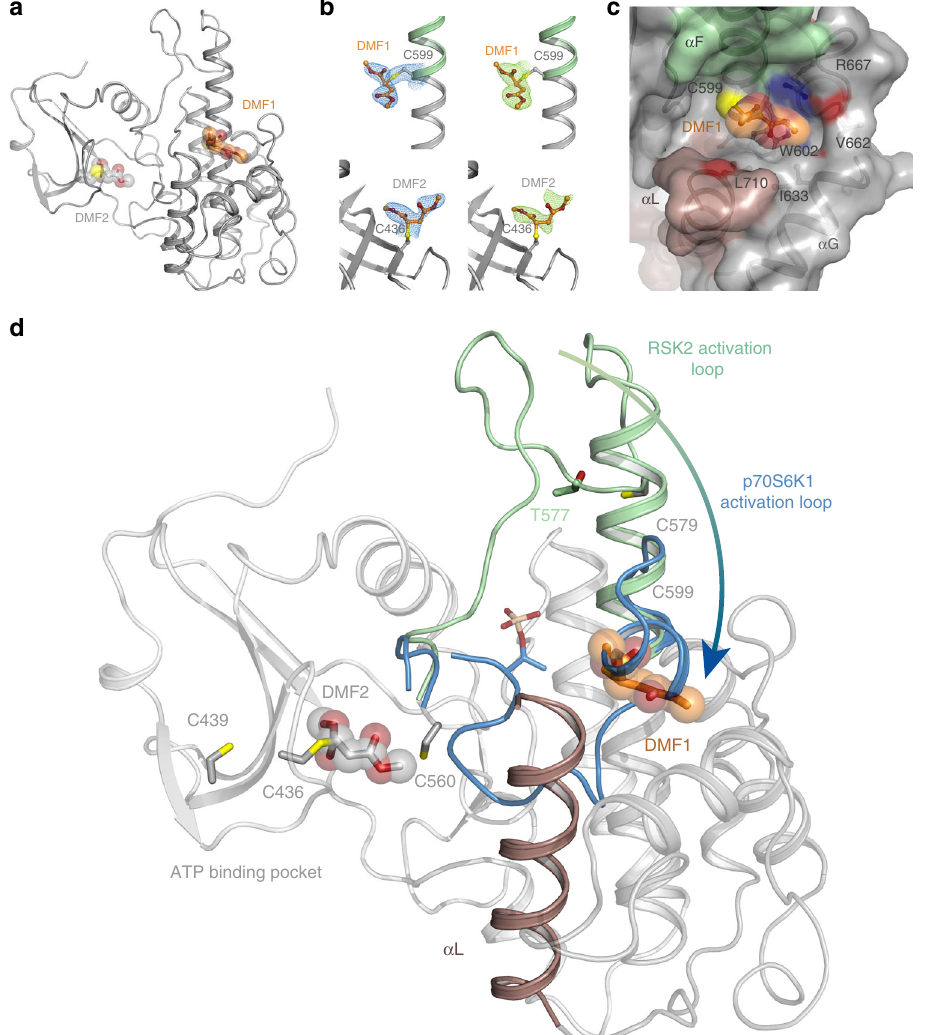
Fig. 2 DMF binds to C436 and C599 in RSK2 crystals. a Cartoon representation of RSK2 with DMF covalently bound at C599 (DMF1) and C436 (DMF2). b Covalent binding of DMF (orange) to C599 and C436 of RSK2 (light grey). Final 2F o – F c electron density map depicted in blue represent a contour level of 1.0 σ and a bias-reduced simulated annealing F o – F c difference maps is contoured in green at 3.0 σ , both on the C436 and C599 dimethyl binding site, respectively. c DMF binding pocket. The regulatory α L-helix, the activation loop, nitrogens and oxygens are coloured in brown, light green, blue, and red, respectively. d Activation of RSK2 (light grey) leads to the phosphorylation of a threonine residue in the activation loop (light green). The movement of the activation loop has been determined by X-ray crystallography for several kinases and is shown in light blue for the related kinase p70S6K1 (PDB ID 3A62). The hinge region is undergoing large structural rearrangements during activation and covalent binding of DMF (in spheres) to C599 could abolish this by steric hindrance. A second DMF modi fi cation site, C436 was observed, but it was less well de fi